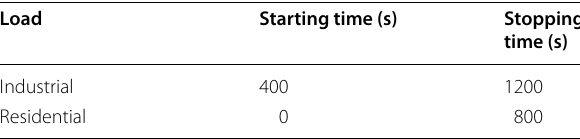
Table 4 Multiple disturbances in load